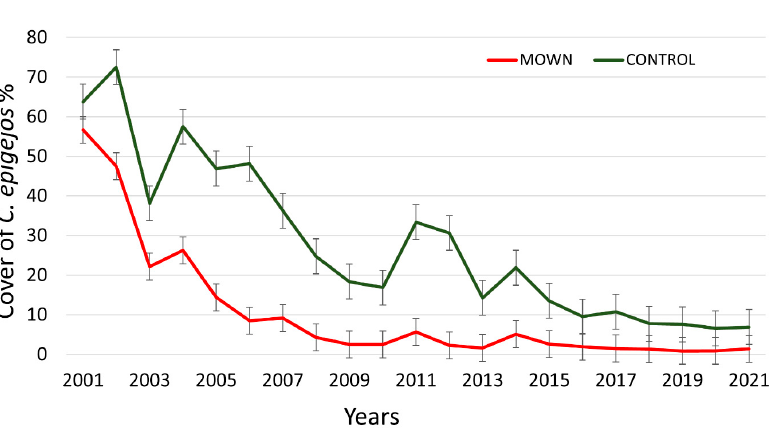
Figure 1. Average cover of C. epigejos in mown and control plots with standard errors during the study period. Table 1. The average cover and standard error of different parameters of mown and control plots. “Total cover absolute” = cover of all vascular plant species; “Cover of CALEPI absolute” = the cover of Calamagrostis epigejos ; “Cover of CALEPI relative” = the cover of Calamagrostis epigejos relative to the overall coverage; “the cover of subordinate species absolute and relative” = cover of all species except Calamagrostis epigejos , “Species richness” = the number of all vascular plant species. For each variable, the same letter shows if the temporal difference between means was not statistically